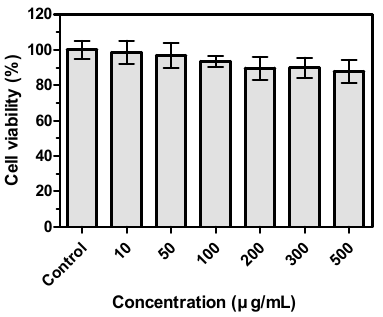
Figure 6. Cytotoxicity evaluation of Eu(TTA) 3 (P(Oct) 3 ) 3 @mSiO 2 @SPION in H460 cells are incubated for 24 h with different concentrations (10, 100, 300 and 500- μ g/mL Eu(TTA) 3 (P(Oct) 3 ) 3 @mSiO 2 @SPION) and their viability is evaluated by MTT assay against untreated control cells. Error bars indicate mean ±SD (n = 12).